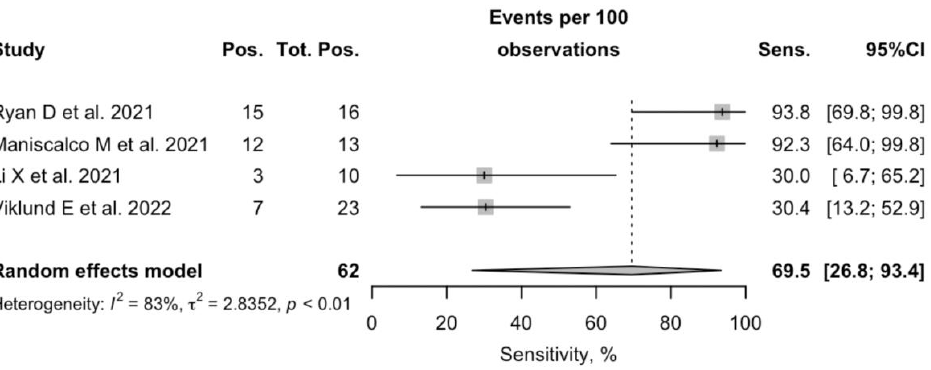
Figure 4. A forest plot representing the estimated sensitivity of SARS-CoV-2 Real-Time Quantitative Polymerase Chain Reaction (RT-qPCR) performed on specimens of exhaled breath condensate. Pooled sensitivity was 69.5% (95%CI 26.8 – 93.4), and heterogeneity was substantial (I 2 82.7%, p = 0.006).